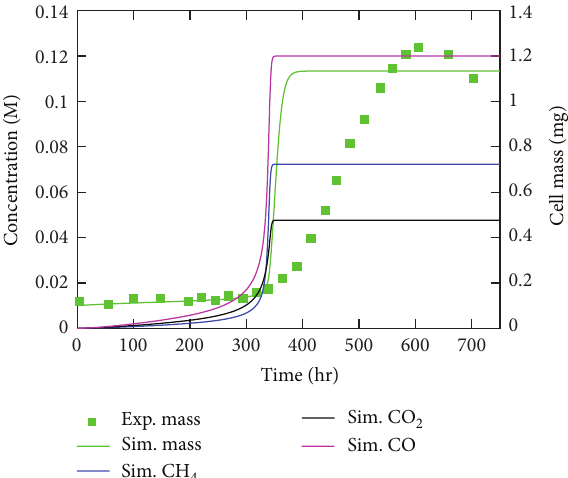
Figure 10: Results of the kinetic model. Comparison of the kinetic model for growth of M. acetivorans culture on 125 mM methanol to the experiment to which it was fit [30]. Lines indicate model results while symbols indicate experimental measurements.